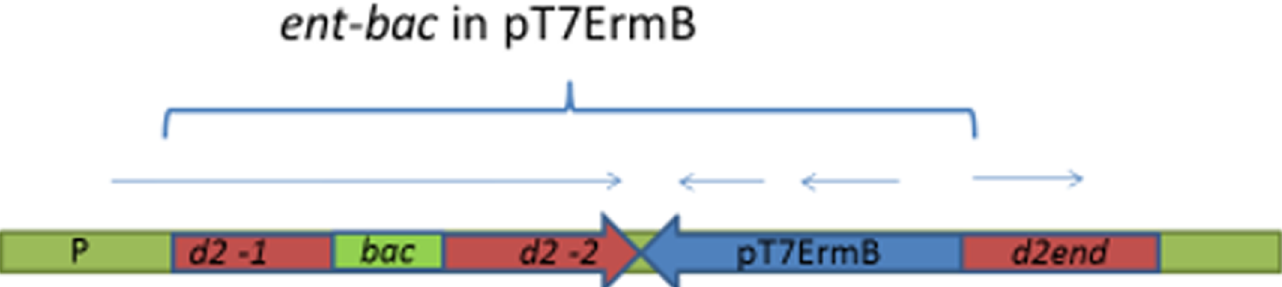
Fig 1. Integration of the plasmid pT7ermB with the ent-bac into the chromosome of the strain E . faecium L3. P-promoter of the gene d2 ; d2 -1-aregion of the d2 gene encoding for N- terminal part of D2 protein; bac - a fragment of the bac gene, encoding for IgA binding; D2-end–end of the d2 gene encoding for the C terminus of D2 protein; pT7 ErmB—integrative plasmid. Arrows correspond to the open reading frames in the integrated element. The entire integrated element ent-bac with plasmid pT7ErmB is shown in brackets.